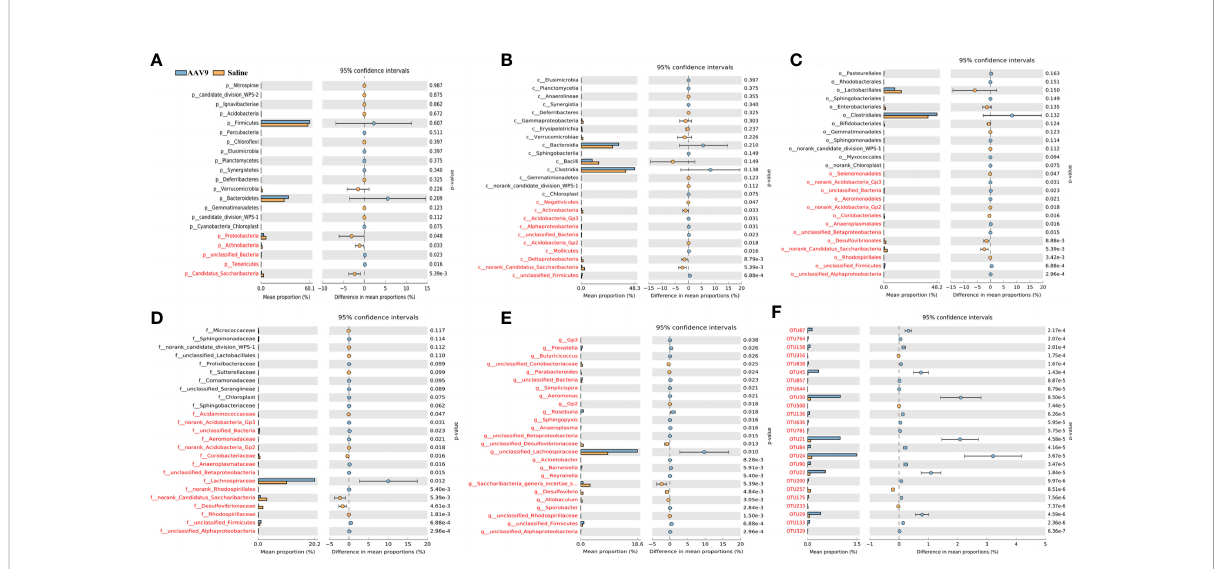
FIGURE 5 Differential abundance of faecal microbiota in the saline and AAV9 groups. The taxa were altered following AAV9 IP injection in the AAV9 group at the phylum (A) , class (B) , order (C) , family (D) , genus (E) , and OTU (F) levels. Blue and orange represent the AAV9 (n = 9) and saline (n = 9) groups, respectively. In each thumbnail, on the left is the abundance ratio of different taxa in the two groups, in the middle is the percentage difference in species abundance within the 95% con fi dence interval, and on the right is the p value. P < 0.05 indicates a signi fi cant difference, marked in red. Notes: At the genus and OTU levels, 25 had the lowest p value.